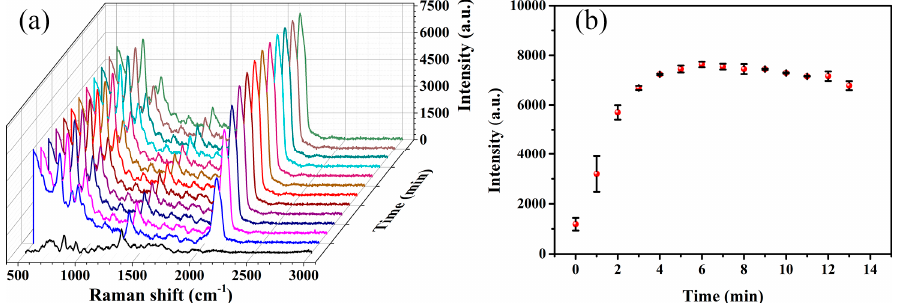
Figure 3. The relationship between surface-enhanced Raman scattering (SERS) spectra and the reaction time (repeated three times). ( a ) SERS spectra with different reaction times. ( b ) The relation curve between Raman spectra intensity (2126 cm − 1 ) and the reaction time.